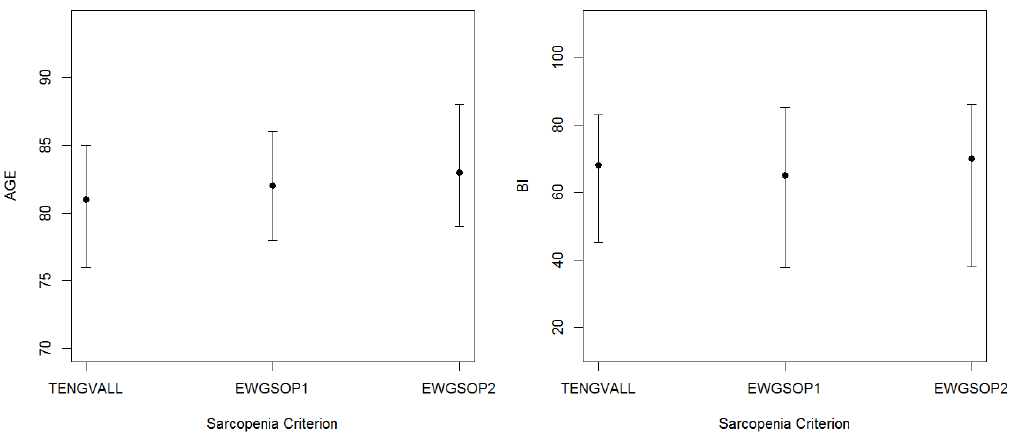
Figure A1. Summary for patients with low ASMI characteristics under each diagnostic criterion. The points represent medians, while lowers are upper quartiles are represented by the vertical bars.